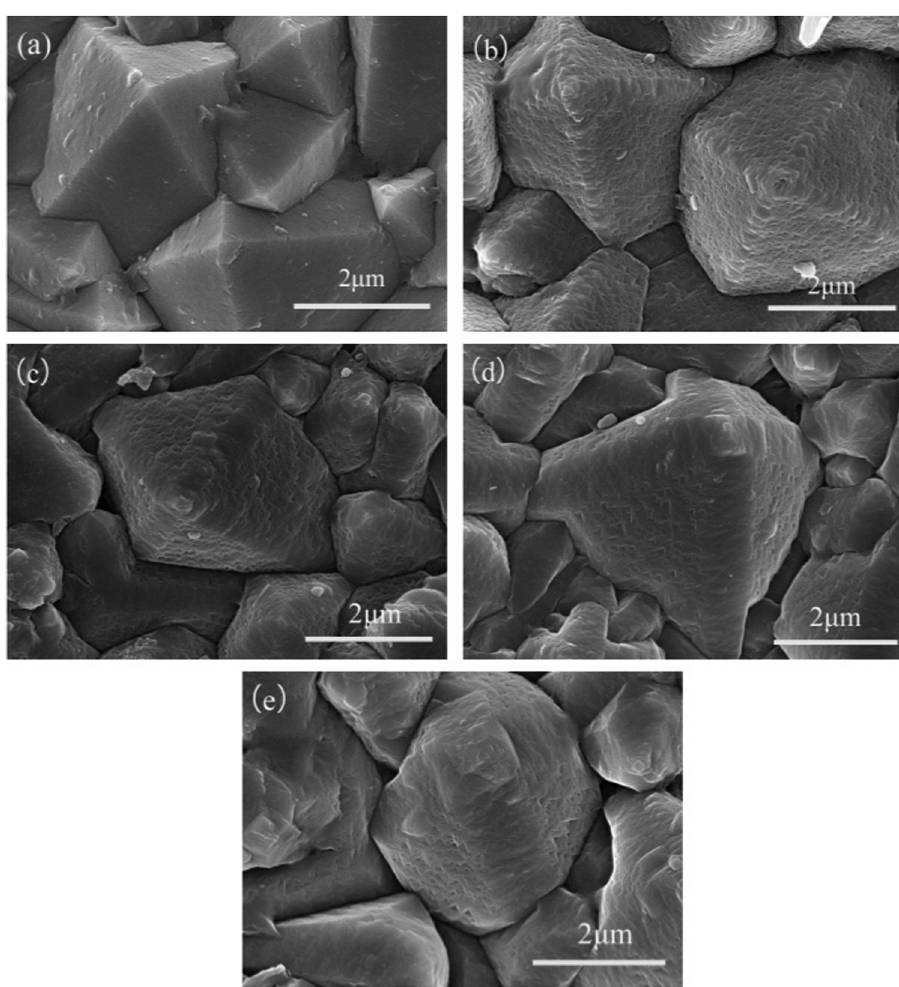
Figure 4: SEM images of samples etched at various times: ( a ) 0, ( b ) 30 min, ( c ) 60 min, ( d ) 90 min, and ( e ) 120